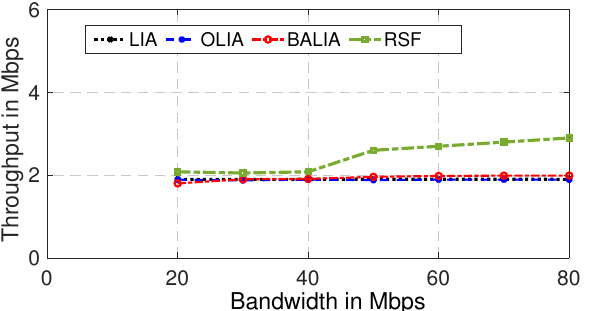
Figure 5. Throughput results for 10 MB file transfer in Scenario 4: heterogeneous bandwidth paths. One path was 20 Mbps, while the bandwidth of the other one was varied. Both paths had 150 ms delay and 4% random packet loss.